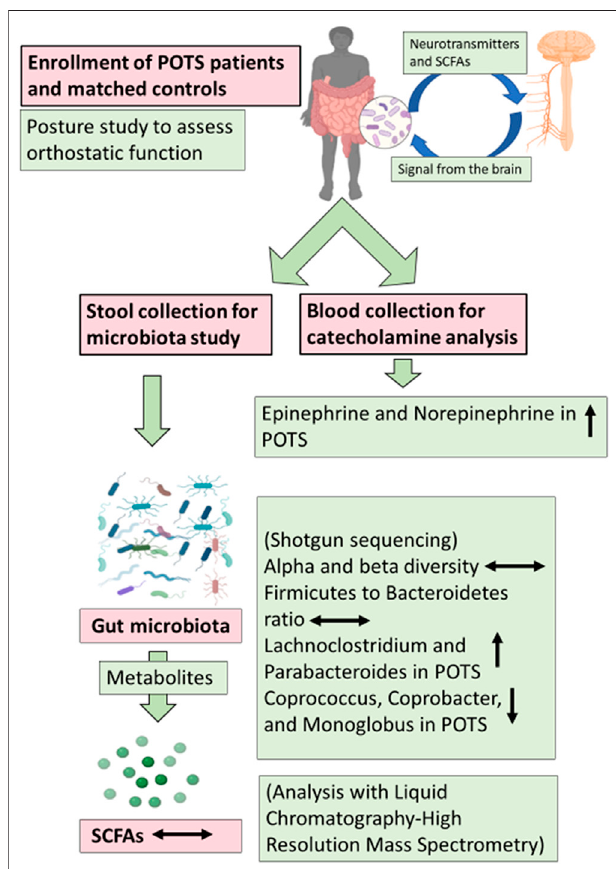
FIGURE 8 | Pictorial depiction of the Summary of the study. POTS patients, 25, and matched controls, 23, were enrolled and a posture study was conducted to assess orthostatic function. Blood and stool samples were collected to perform analysis and gut microbiota was characterized usingshotgunsequencing.Themetabolitesofgutmicrobiotashort-chainfatty acids (SCFAs) were measured with Liquid Chromatography-High Resolution Mass Spectrometry